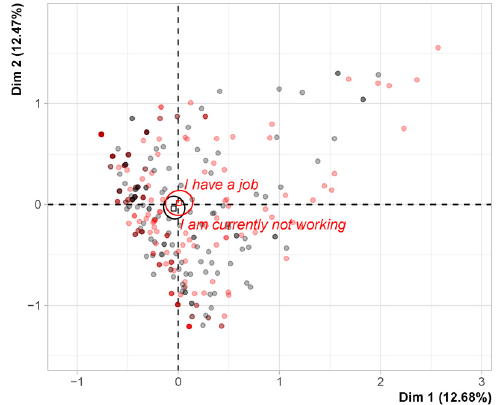
Figure A12. MCA. Distribution of respondents by working status.